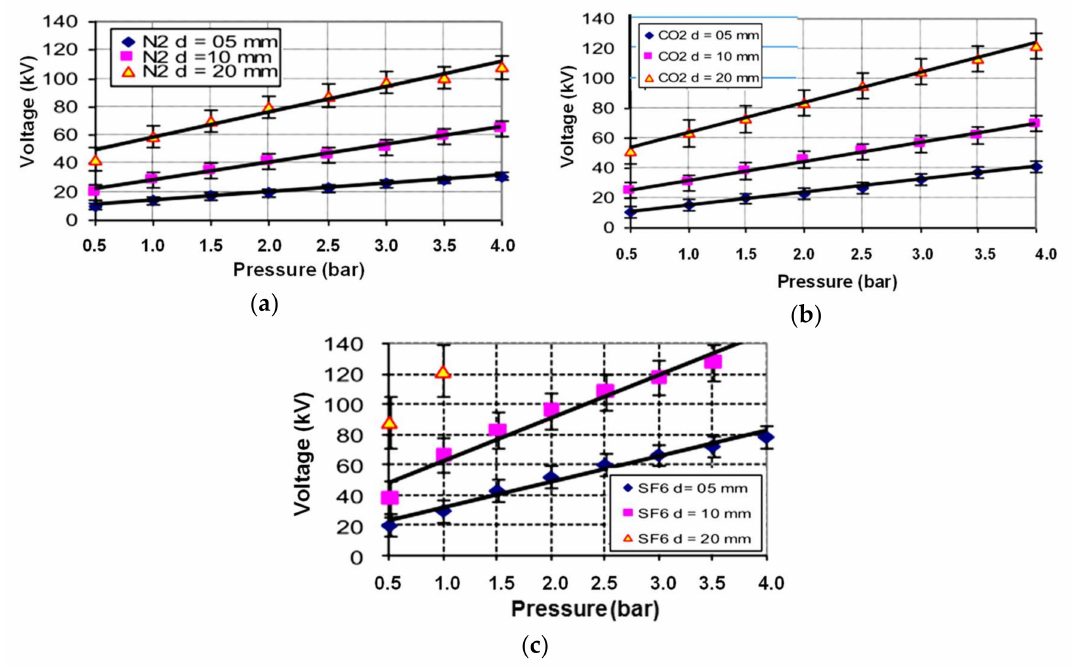
Figure 4. Negative DC breakdown voltage of N 2 ( a ), CO 2 ( b ) and SF 6 ( c ) gases in the point–plane electrode arrangement.